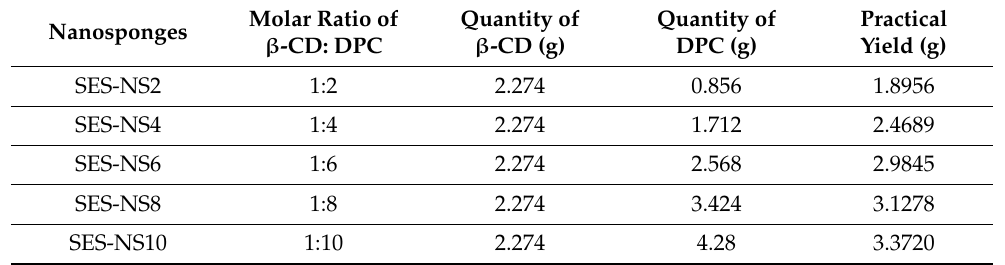
Table 1. Composition of prepared nanosponges.